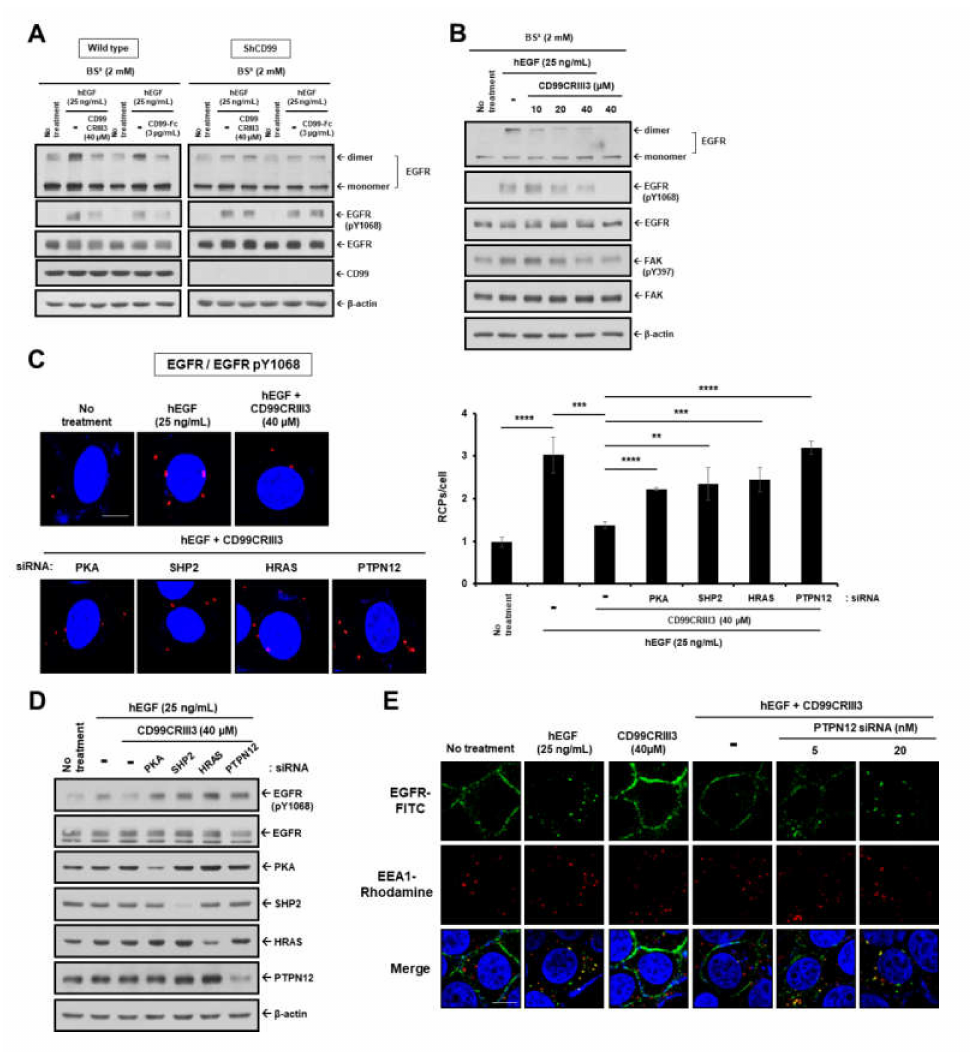
Figure 4. CD99 agonistic ligands inhibit EGFR dimerization and endocytosis via the PKA / SHP2 / HRAS / ERK / PTPN12 signaling pathway. ( A , B ) For dimerization assay, wild type or CD99 shRNA stable-expressing MDA-MB-231 cells were treated with CD99CRIII3 or CD99-Fc in the presence of EGF (25 ng / mL) for 1 h on ice. Cells were subjected to BS 3 chemical-mediated crosslinking. Cell extracts were subjected to SDS-PAGE to assess EGFR dimerization and phosphorylation levels of EGFR at Y1068 and FAK at Y397 and the expression levels of indicated proteins. β -actin was used as a loading control. ( C ) In MCF-7 cells, dimerization of EGFR was assessed by in situ PLA. ** p < 0.01; *** p < 0.001; **** p < 0.0001. ( D ) Whole cell lysates extracted from MDA-MB-231 cells treated with EGF with or without CD99CRIII3 were subjected to SDS-PAGE to examine the phosphorylation levels of EGFR and expression levels of each target protein. ( E ) EGFR endocytosis in MCF-7 cells treated with EGF or CD99CRIII3 either alone or combined. ( C , E ) Original magnification of representative images, 600 × . Scale bars = 10 µ